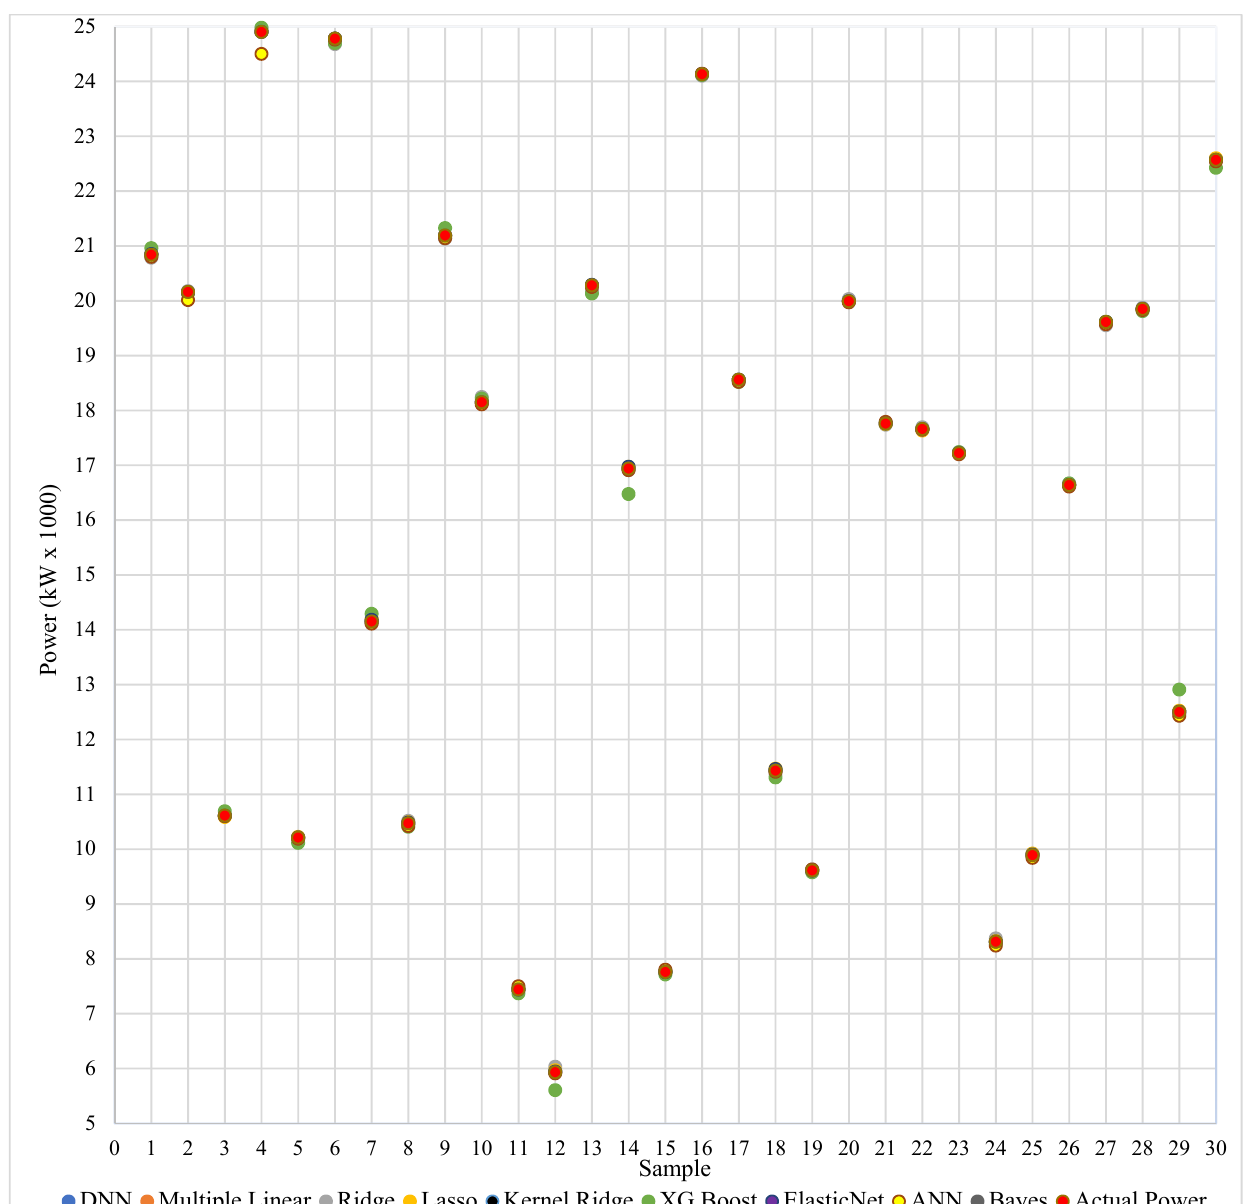
Figure 8. Comparison of actual power with predictions.